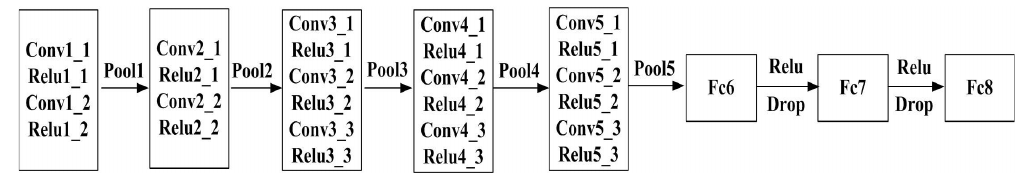
Figure 11. The schematic diagram of VGG16.